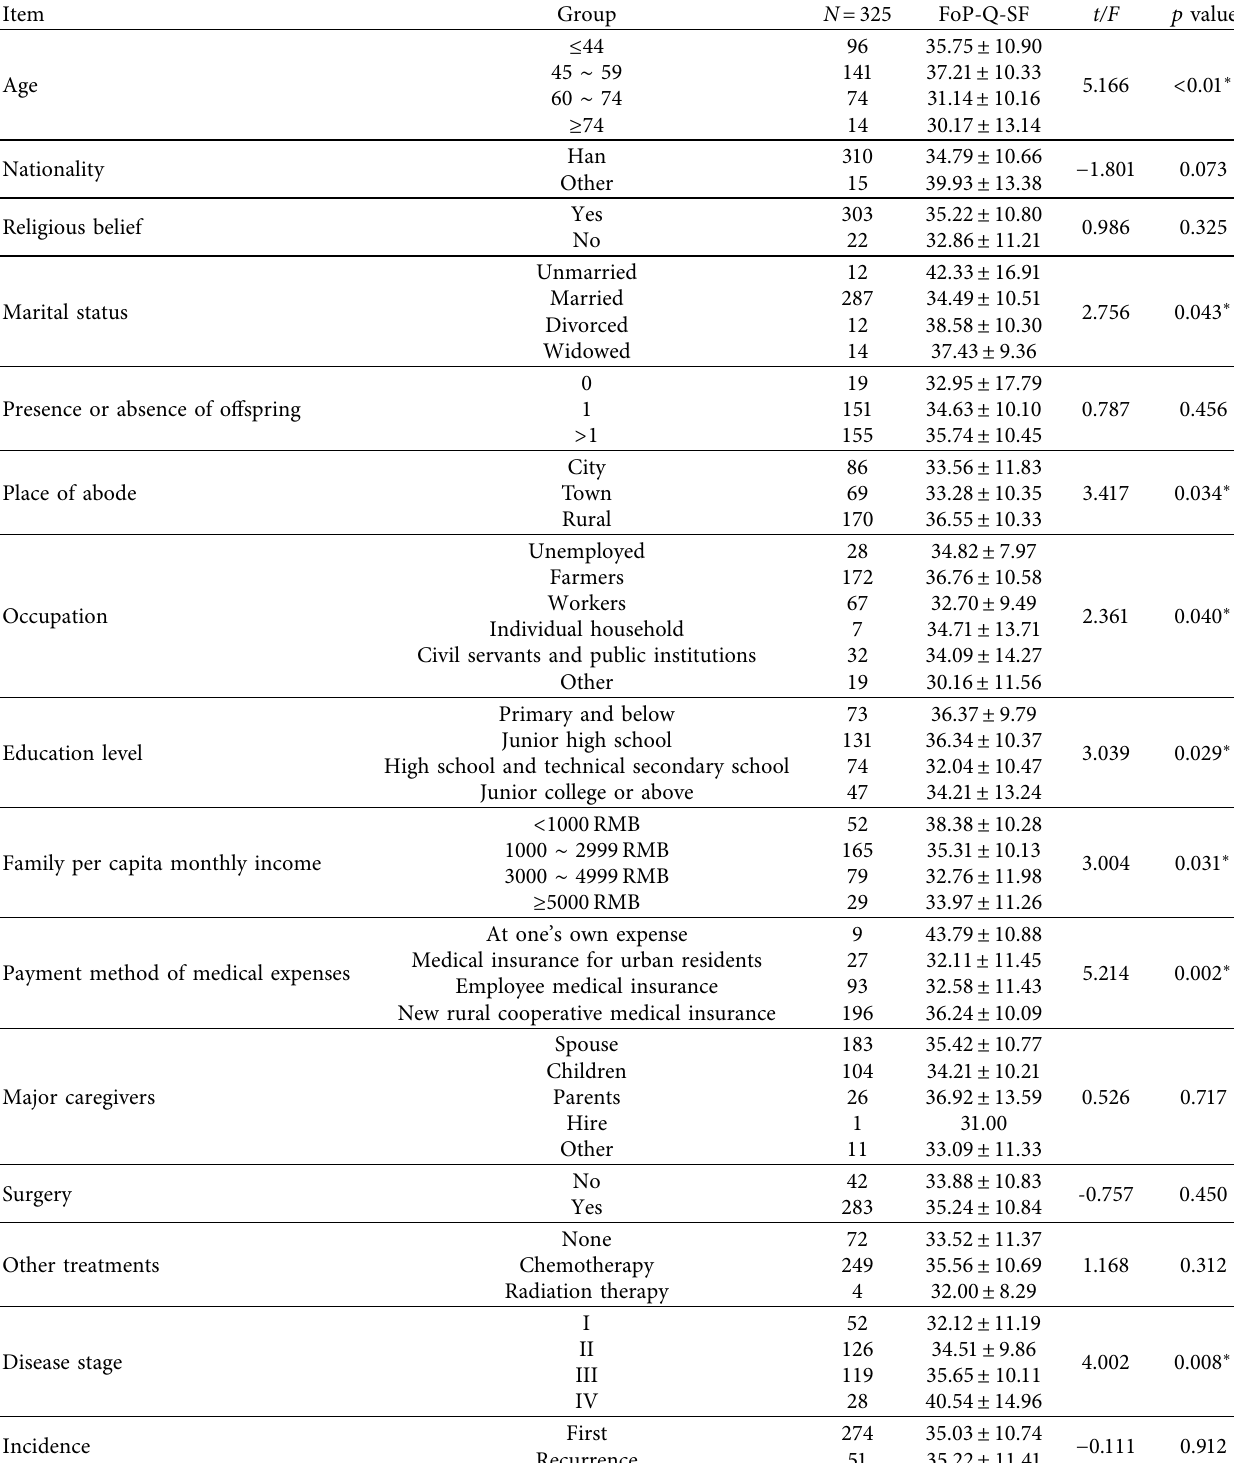
Table 1: Te FoP-Q-SF score of breast cancer patients in general demographic and disease related data ( χ ± s )